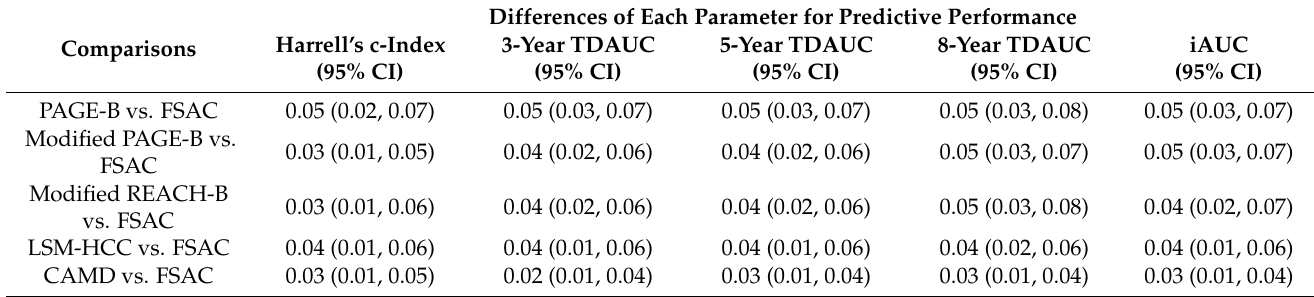
Table 4. Comparison of predictive performance between the FSAC and other HCC risk-prediction